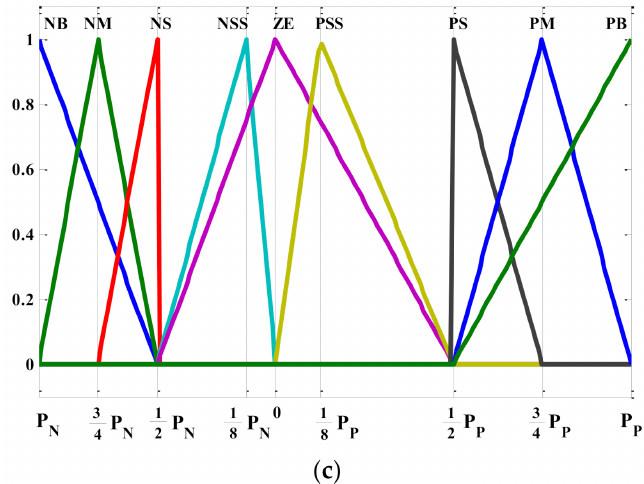
Figure 4. Fuzzy controller membership functions (MF): ( a ) Power forecast error, ( b ) battery state-of-charge (SOC), and ( c ) fuzzy logic control (FLC) output [45]. ©2016 IEEE, Reprinted, with permission, from Arcos-Aviles D, Guinjoan F, Marietta MP, Pascual J, Marroyo L, Sanchis P. Energy management strategy for a grid-tied residential microgrid based on Fuzzy Logic and power forecasting. IECON 2016—42nd Annu. Conf. IEEE Ind. Electron. Soc., Florence, Italy: IEEE; 2016, pp.